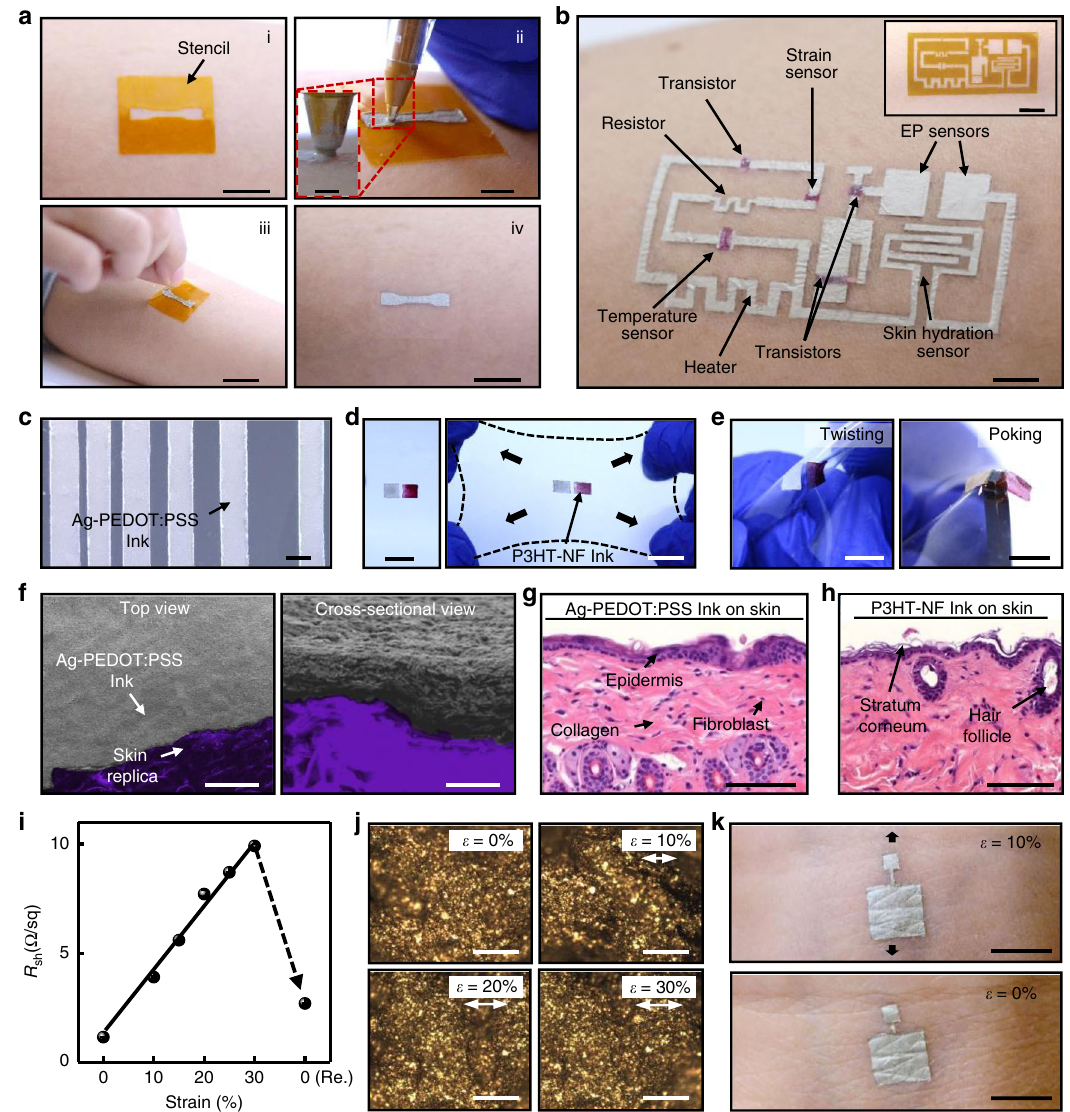
Fig. 1 DoS electronics platform featuring conductive and semiconducting inks. a DoS electronics drawing process beginning with (i) a tape-based stencil attachment to the skin (scale bar 1 cm), (ii) drawing the device with the stencil, modi fi ed ballpoint pen, and inks (scale bar 5 mm), inset is a closeup of the tip (scale bar 1 mm), (iii) removal of the stencil (scale bar 2 cm), and (iv) the completed device after drying (scale bar 1 cm). b An example DoS integrated system including a resistor, transistors, heater, EP (electrophysiological) sensors, temperature sensor, strain sensor, and skin hydration sensor drawn on human skin (scale bar 5 mm). The corresponding stencil for the conductor is shown in the inset (scale bar 1 cm). c Achievable line spacing using stencils and the conductive Ag-PEDOT:PSS ink (scale bar 1 mm). d Non-stretched (left, scale bar 1 mm) and biaxially stretched (right, scale bar 1 cm) states of the drawn structure consisting of Ag-PEDOT:PSS conductive (left square) and P3HT-NF semiconducting (right square) inks on PDMS. e Twisting (left) and poking (right, scale bars 1 cm) deformations of the drawn structure with conductive and semiconducting inks. f SEM images of the Ag-PEDOT:PSS ink showing ultraconformal contact with the grooves and bumps (left, scale bar 250 µ m) on top of skin replica and cross-section showing Ag-PEDOT:PSS microstructure (right, scale bar 20 µ m). The purple color indicates the skin replica. g Histology image of the Ag-PEDOT:PSS ink on skin of mice after 48 h (scale bar 100 µ m). h Histology image of the P3HT-NF ink on skin of mice after 48 h (scale bar 100 µ m). i Sheet resistance vs. strain while stretching the Ag-PEDOT:PSS ink up to 30% and releasing. The error bars represent the s.d. j Optical microscope images of the Ag-PEDOT:PSS ink on skin replica stretched up to 30% (scale bars 100 µ m). k DoS EP sensor on the wrist of subject in stretched (top) and non-stretched (bottom) states (scale bars 5